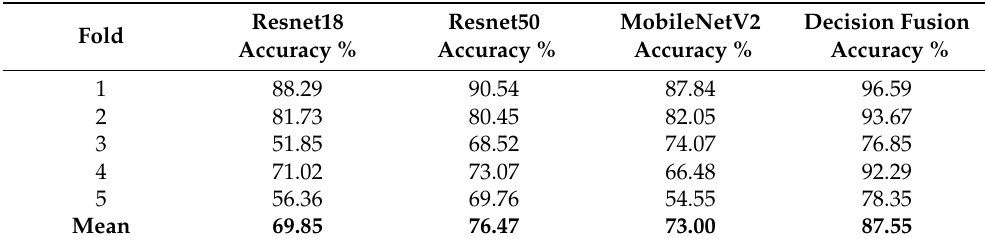
Table 5. Comparison of the classification performance of each single-scale classifier and a single-scale ensemble of classifiers.